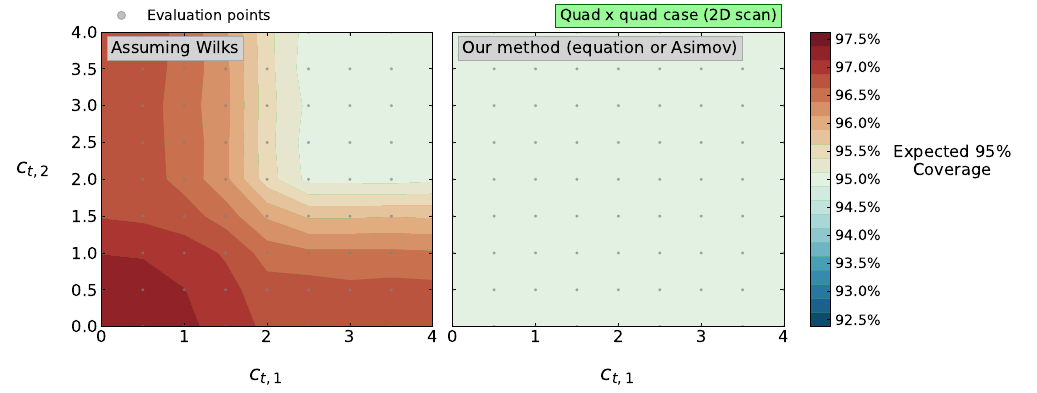
Figure 9: Expected 95 % coverage assuming Wilks (left) and using our method (right) = ( − 0.5,0.3 ) , ¯ n = ( 0.8,0.1 ) and a strong negative cor- for a 2D example with ¯ n 1 2 relation of ρ = − 0.79. Our method provides correct coverage for all c true